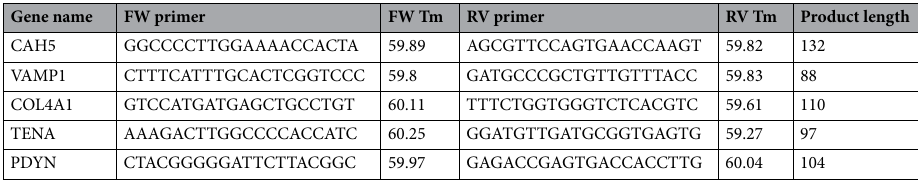
Table 1. Primer sequences used for qPCR validation of differential expression of selected